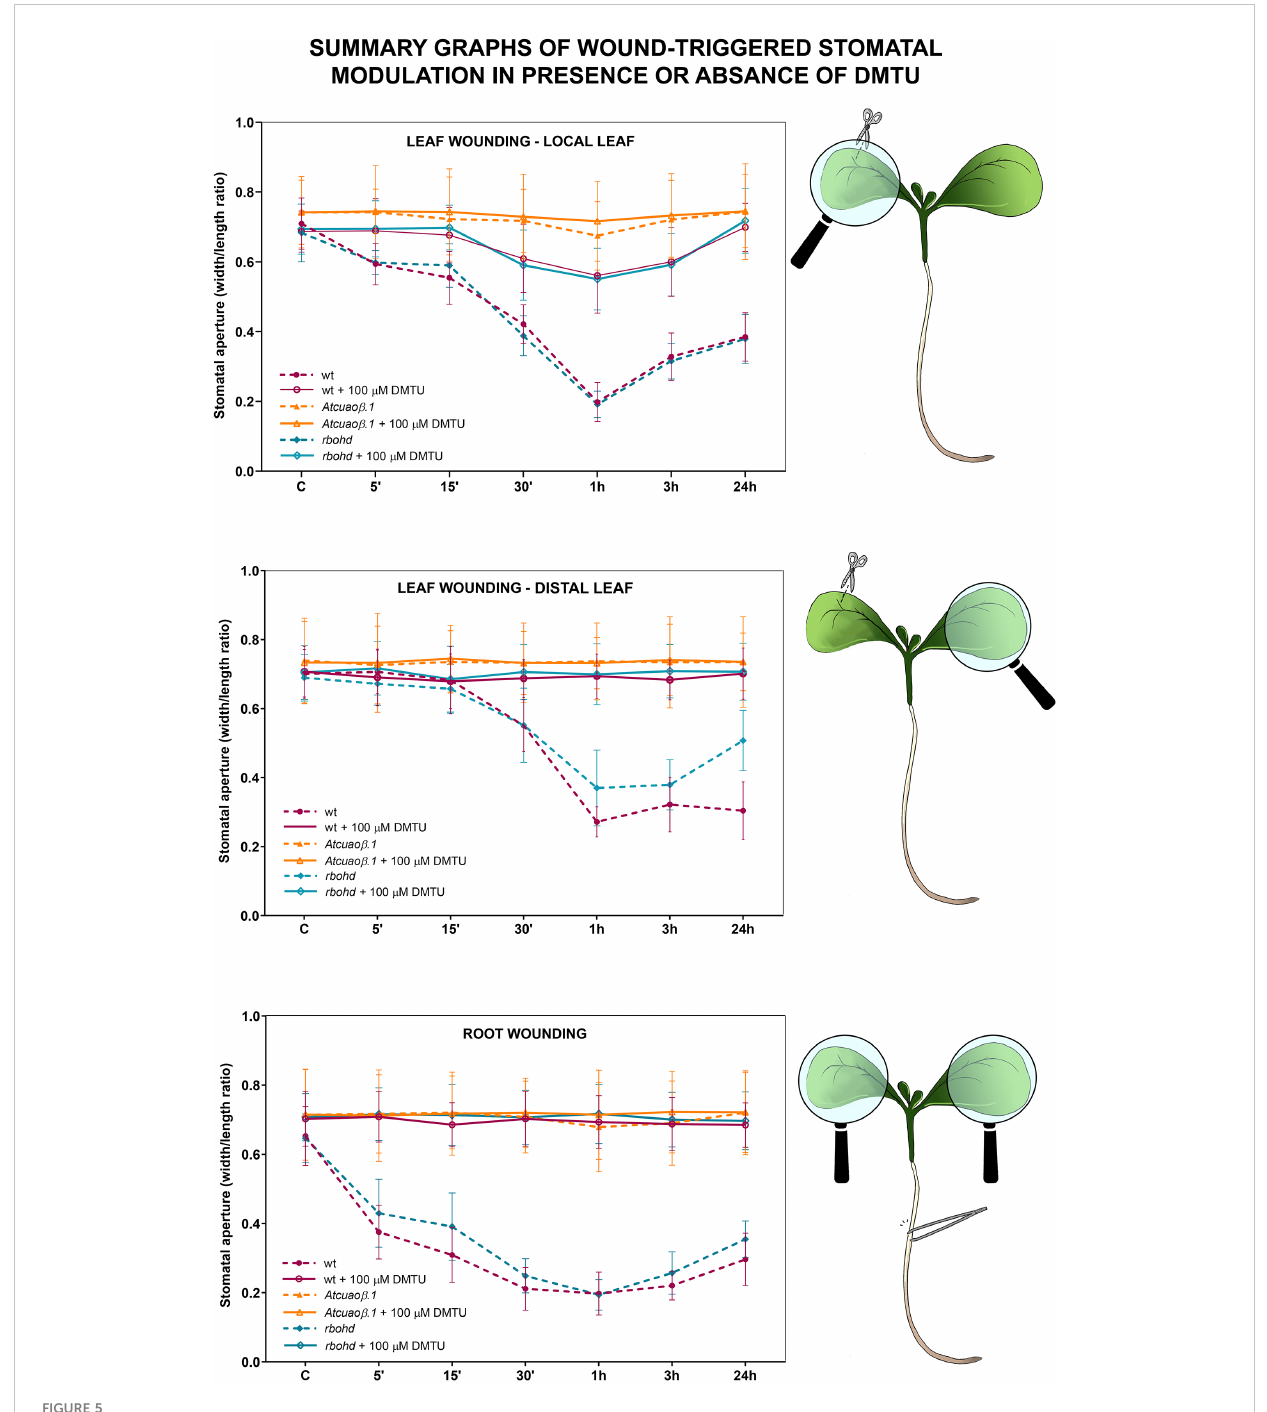
FIGURE 5 Summary graphs of data from Figures 1, 3, and S1, showing stomatal aperture modulation by local or distal wounding and/or DMTU treatment in WT, Atcuao b , and rbohd